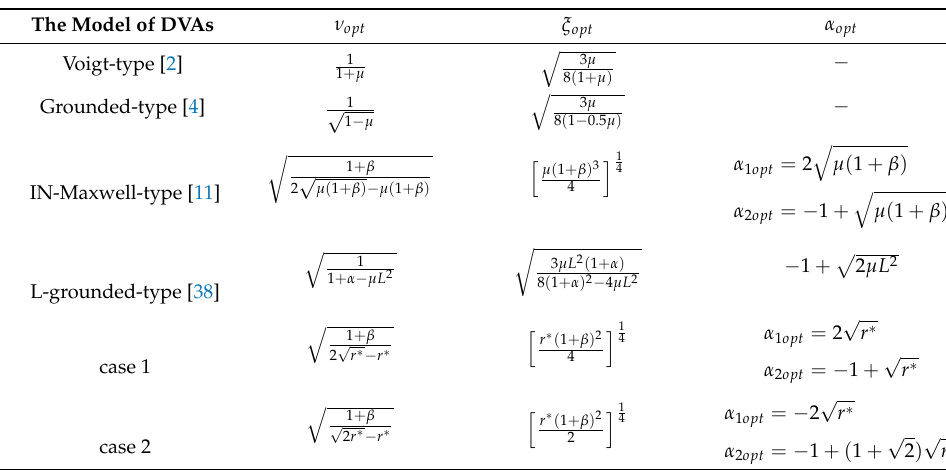
Figure 10. The classical models of DVAs: ( a ) Voigt-type. ( b ) Grounded-type. ( c ) IN-Maxwell-type. ( d ) L-grounded-type. Table 3. The formulas of optimal parameters of